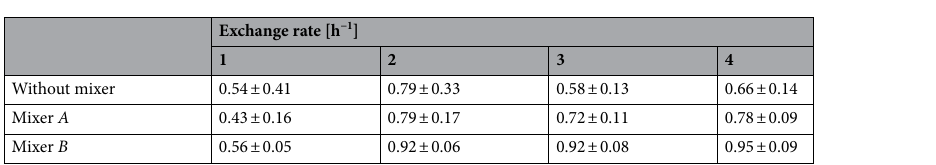
Emission from a 3D printer. Total concentration. Figure 6 depicts the ABS emission data for small and large particles generated during the whole process, at different temperature settings and printing times. The